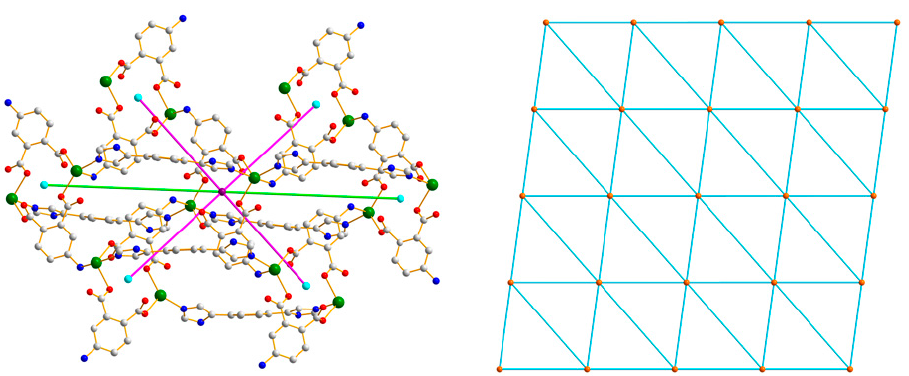
Figure 3. 2D framework of Cd(II)(H 2 L)(nobda) 2 − in 1 . Crystals 2018 , 8 , x FOR PEER REVIEW